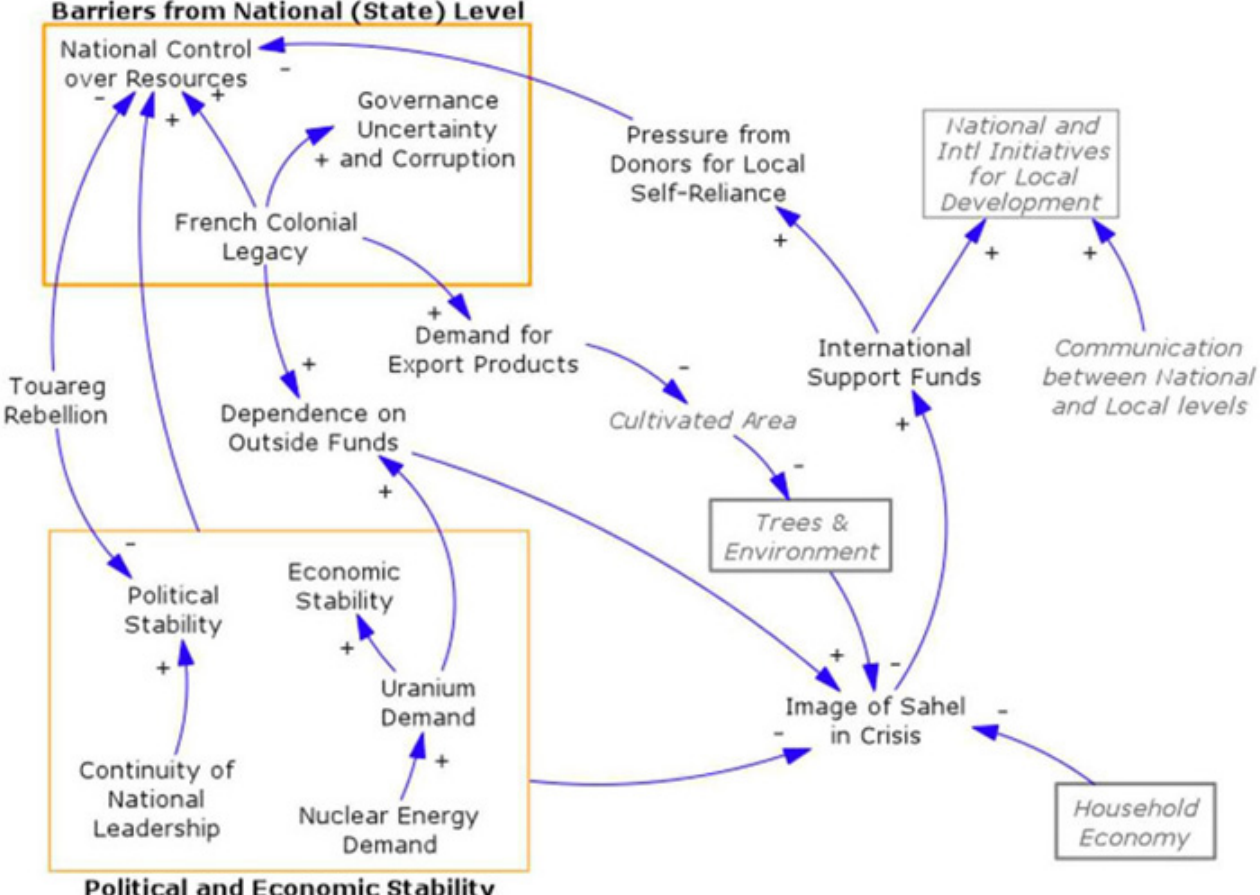
Fig. 9 . National capacity to govern in Niger: relations between environmental and socio-political factors modeled at regional-to-international